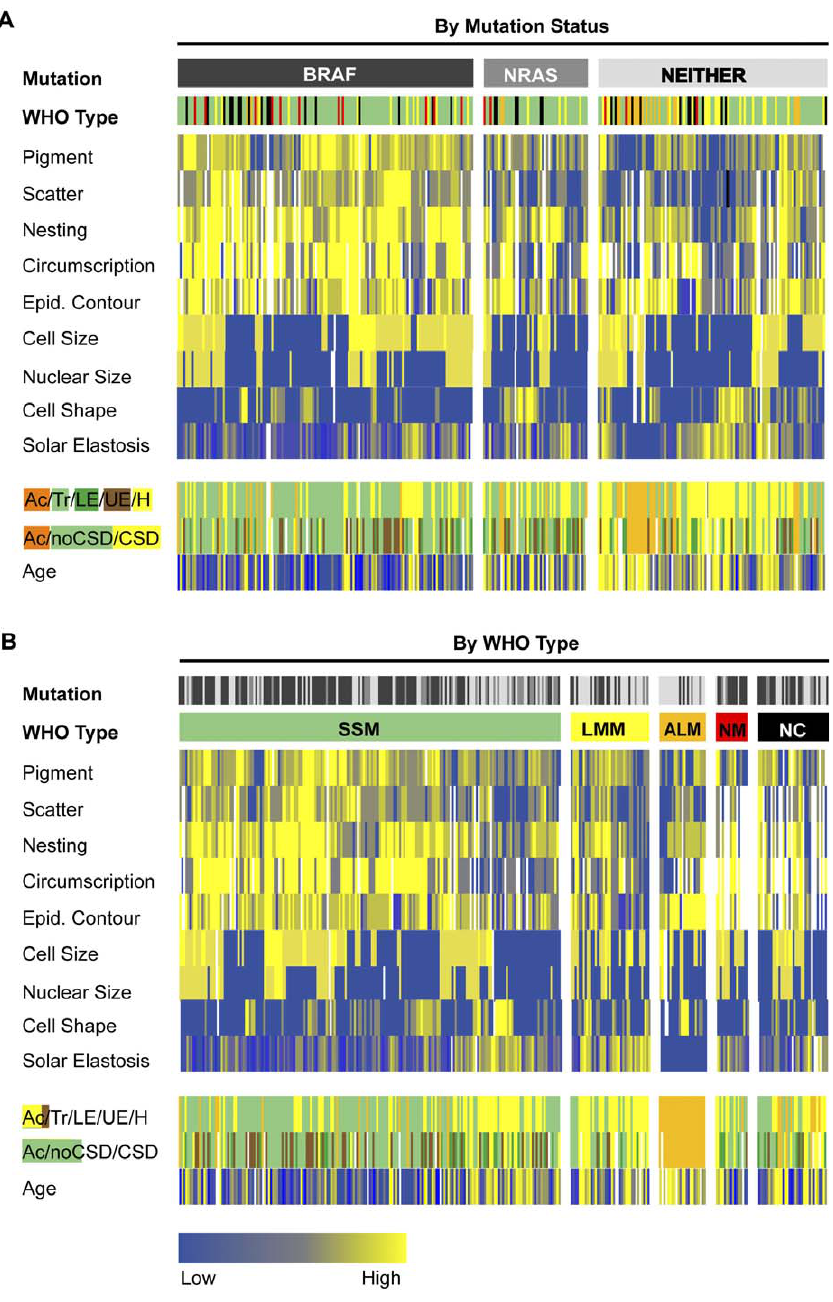
Figure 2. Heatmap of Features by Mutation Status (A) and by WHO Subtypes (B) Variables significantly associated with BRAF . Samples are in columns, variables in rows. The scores range from shades of blue (low score), to gray (intermediate scores), to yellow (high scores). Samples are ordered within each category using agglomerative hierarchical clustering on morphological variables by Euclidean distance and Ward’s criterion. Ac, acral; CSD, chronic sun damage as defined in [12]; H, head; LE, lower extremity; Tr, trunk; UE, upper